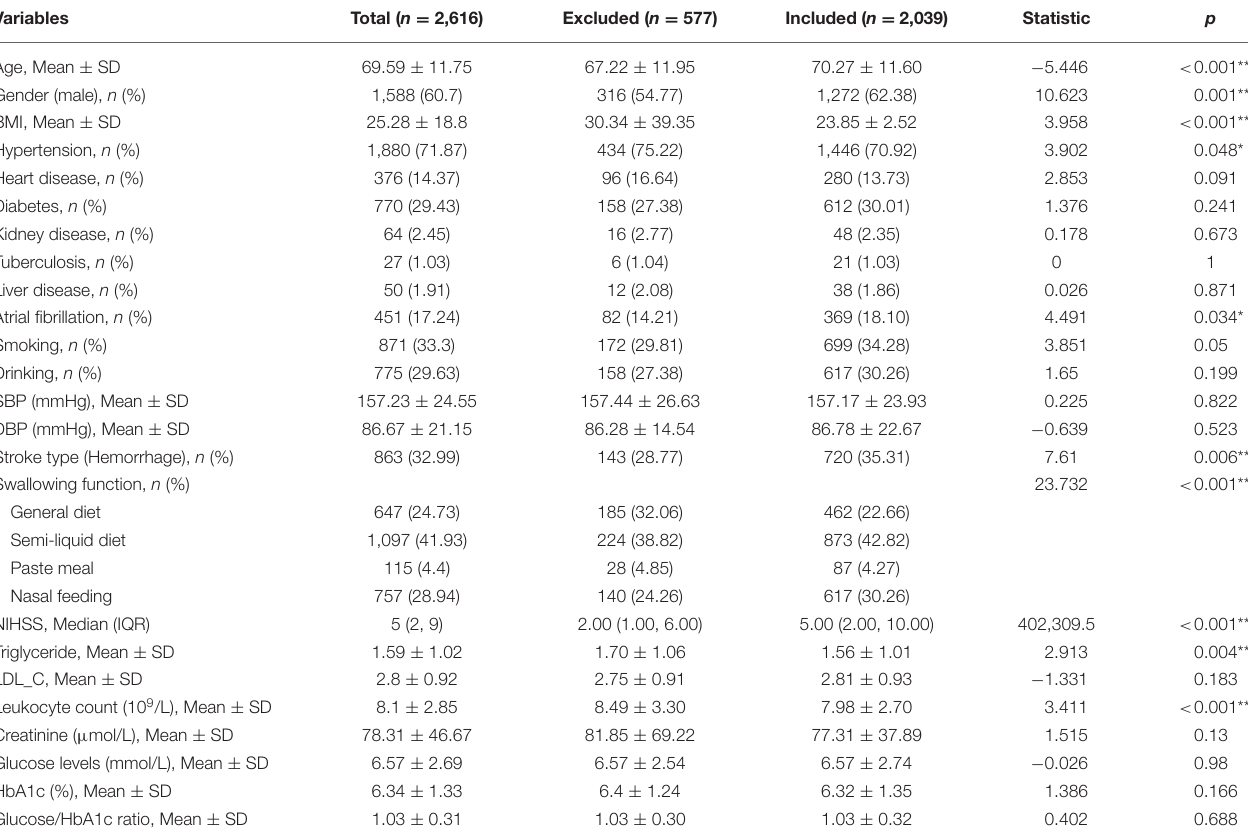
TABLE 2 | Comparison of characteristics between included and excluded patients.